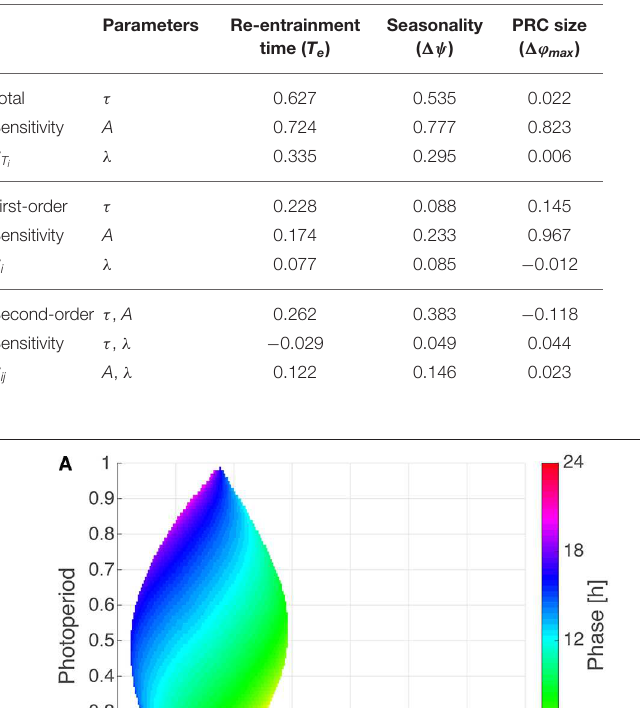
TABLE 1 | Sobol’s global sensitivity analysis, showing dependence of the entrainment features (re-entrainment time: T e , maximum shift: 1ϕ max , seasonal variability: 1ψ ) on the model parameters (intrinsic period: τ , amplitude: A , relaxation rate: λ ).